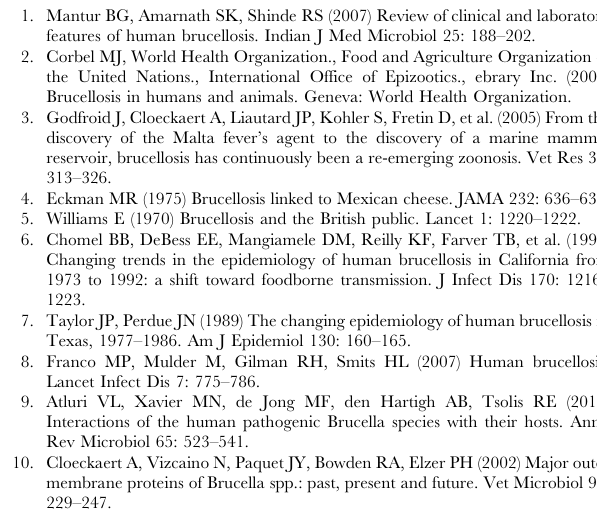
Figure 7. Cytokine production in splenocytes derived from mice inoculated with a cocktail of proteins BtuB, Hia, and FlgK, B. abortus S19 lysate, ISCOMTRIX adjuvant, or PBS. Groups of 3 C57BL/6 mice were inoculated subcutaneously twice three weeks apart and humanely euthanized 3 weeks after the last inoculation. Spleens were harvested and processed into a single cell suspension. Splenocytes were plated and stimulated with individual Brucella outer membrane proteins, S19 lysate, ISCOMATRIX adjuvant or RPMI media. Supernatants were collected 24 hrs post-stimulation and analyzed for cytokines using the Th1/Th2 bioplex kit or indirect ELISA (IL-17A). Data represent mean + / 2 standard error of the mean from each group of 3 mice. Statistical significance between PBS control and treatment groups was determined with one-tailed